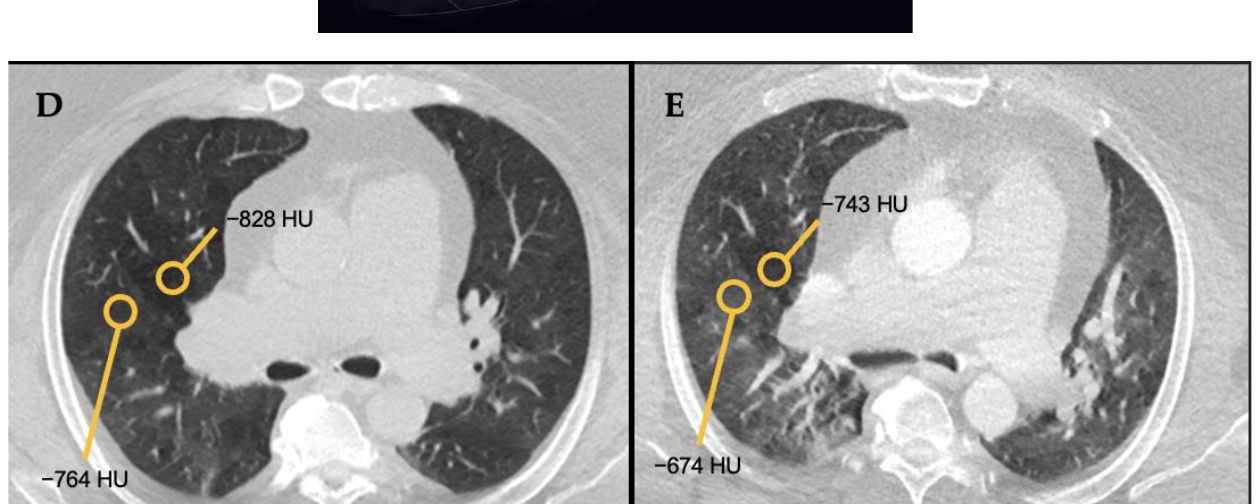
Figure 5. Mosaic perfusion ( C ). Axial ( A ) and coronal ( B ) inspiratory phase CTs show sharply demarcated regions of low attenuation (asterisk) interspersed in a background of normal (high) lung attenuation. Small caliber of vessels (short arrow) in the lucent areas relative to the normal lung vasculature (long arrow). Similar gradient of attenuation between low and high attenuation areas measuring 64 HU during inspiration ( D ) and 69 HU during expiration ( E ) indicating small vessel disease. Notice the expected decrease in volume of both hypo- and hyper-attenuating areas ( E ) .